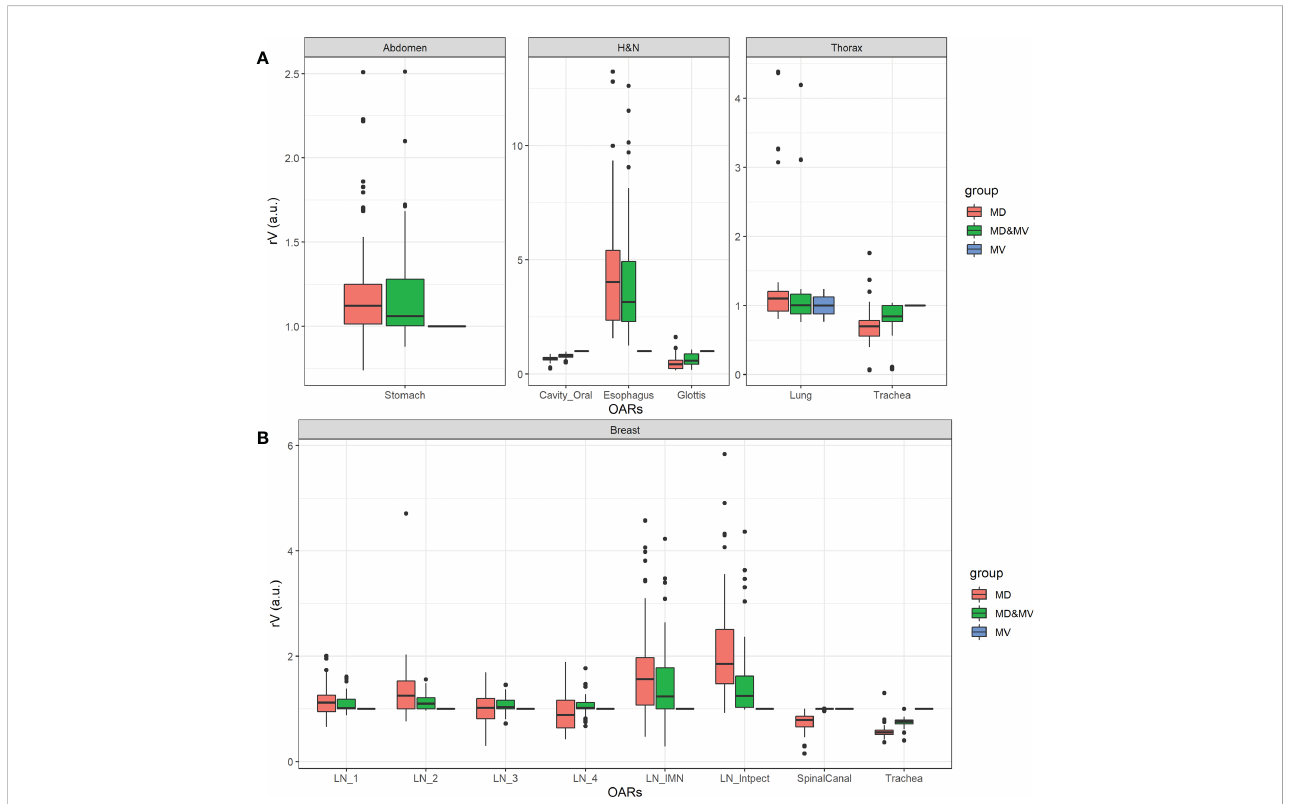
FIGURE 5 Boxplot of rV of delineated OARs and districts in which the manually adjusted VOIs showed a difference higher than 10% compared to MV alone (i.e., rV lower than 0.9 or higher than 1.1) in less than 75% of MD&MV cases. The relative volume differences observed in the abdomen, H&N, and thorax districts are shown in panel (A) , while for breast cancer patients in panel (B) . See the de fi nition of Figure 1